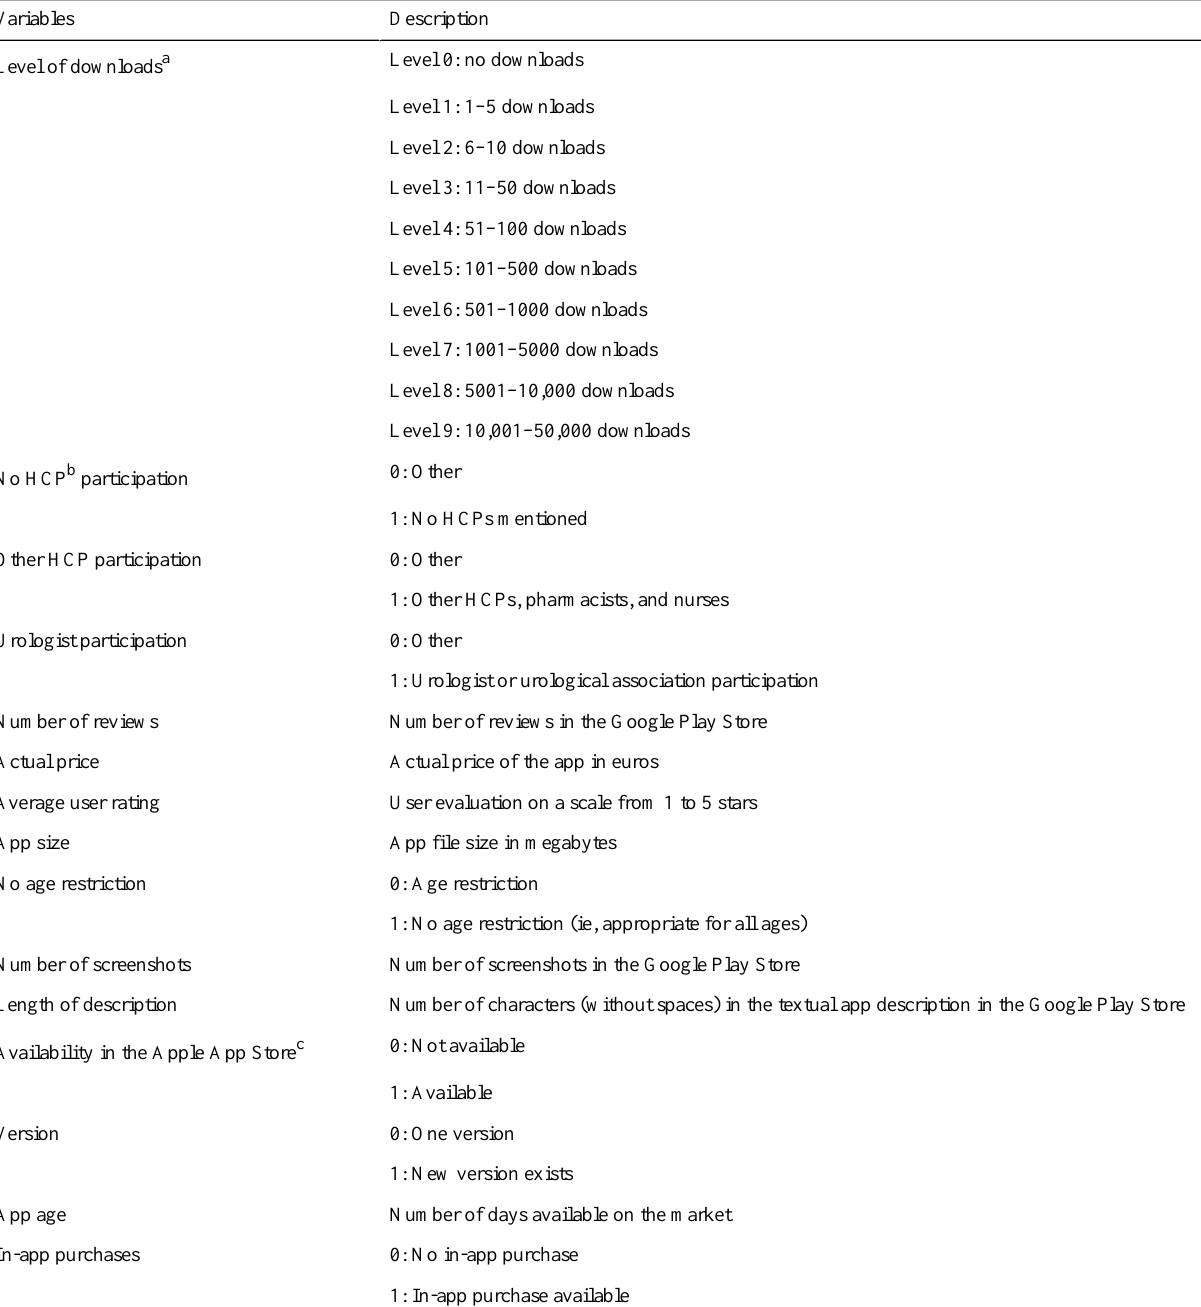
Table 1. Variables included in the model to predict the number of downloads of urology